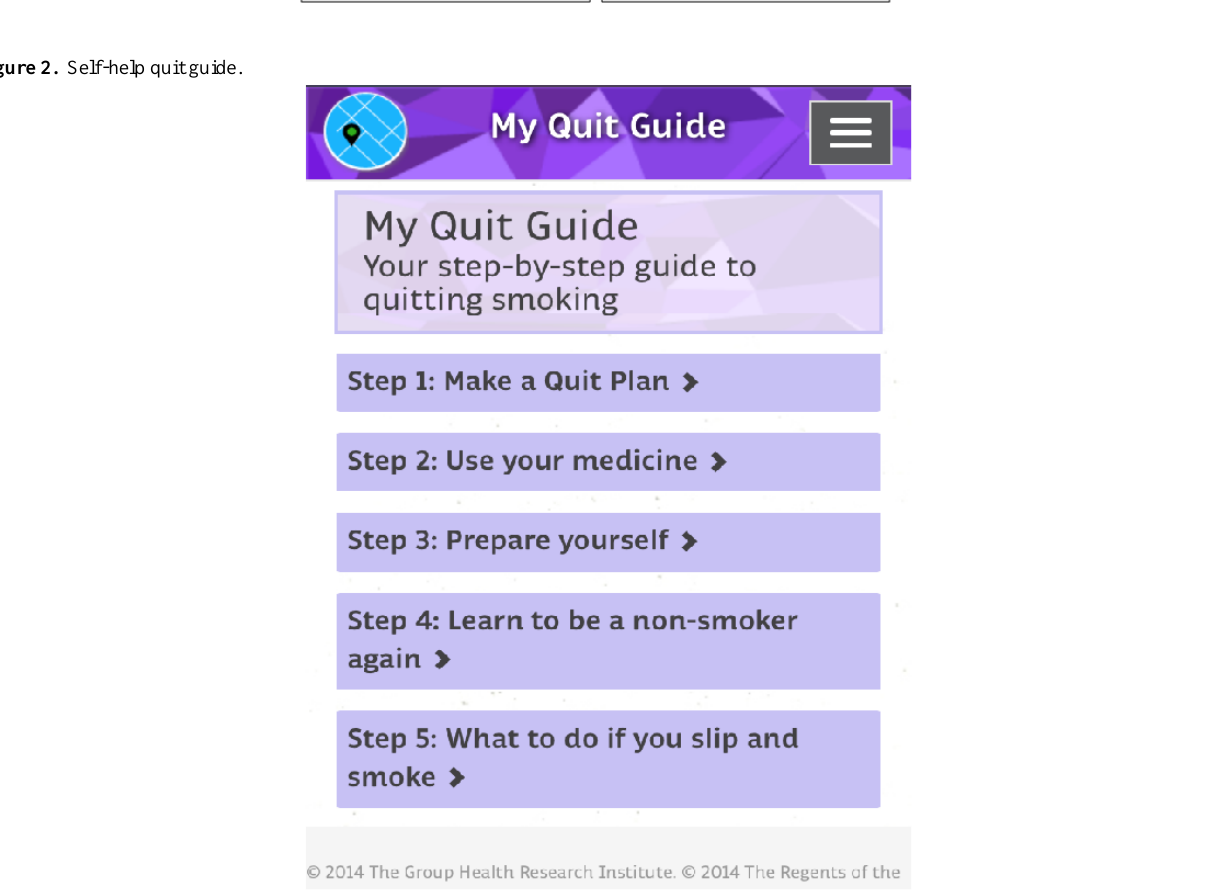
Figure 2. Self-help quit